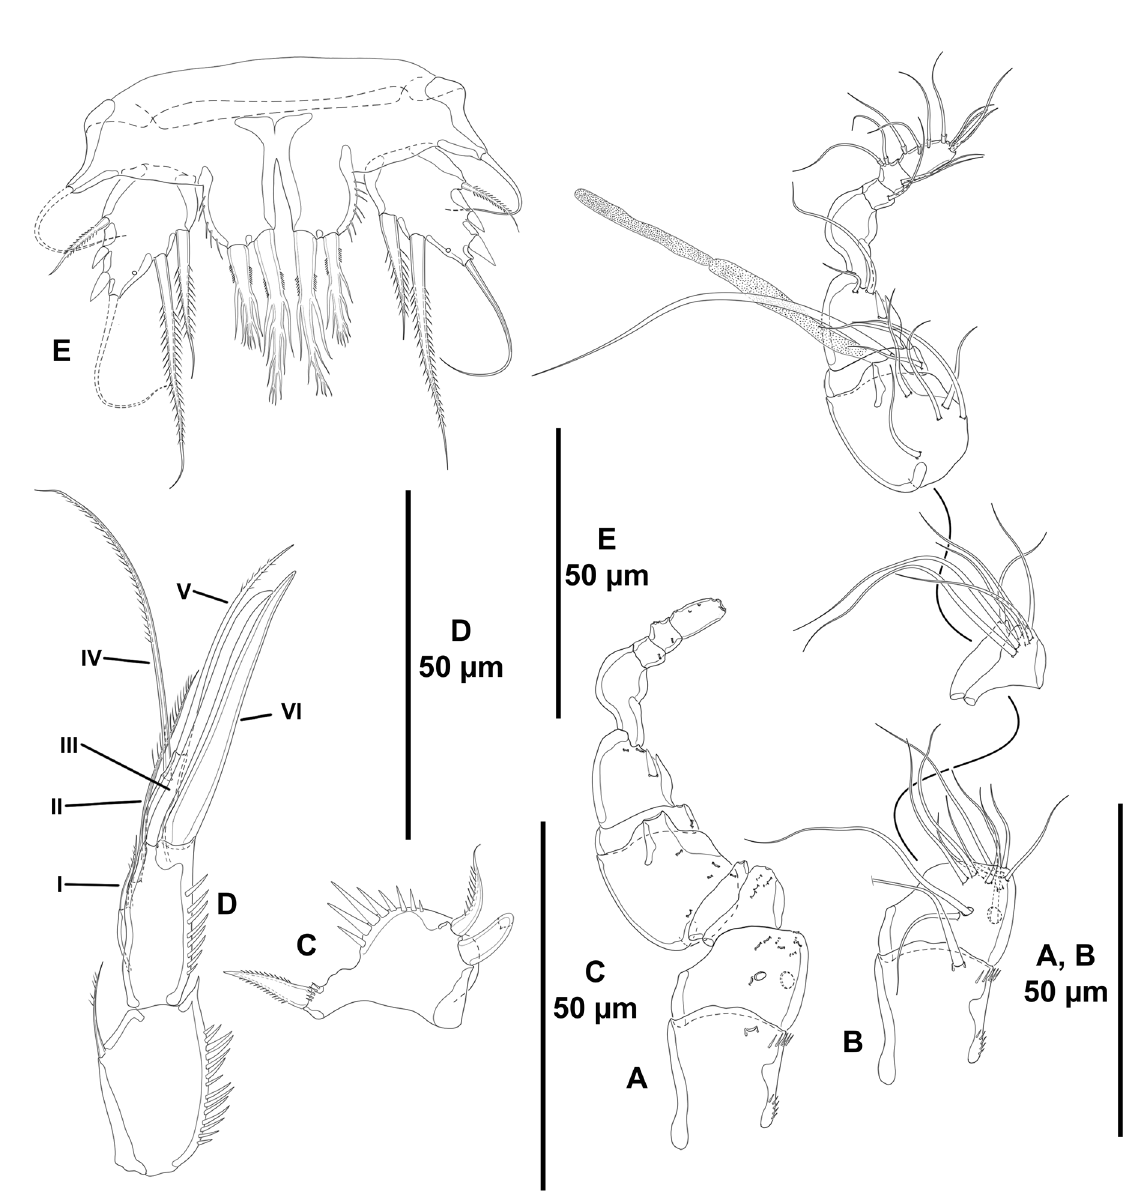
Fig. 18. Spinodiosaccus primus gen. et sp. nov. A–B, E . Paratype, ♂ (ICML-EMUCOP-180119-68). C–D . Paratype, ♂ (ICML-EMUCOP-180119-69). A . Antennule (armature omitted for simplicity). B . Antennule showing armature. C . Basis of P1, anterior view. D . P2 ENP. E . P5, anterior